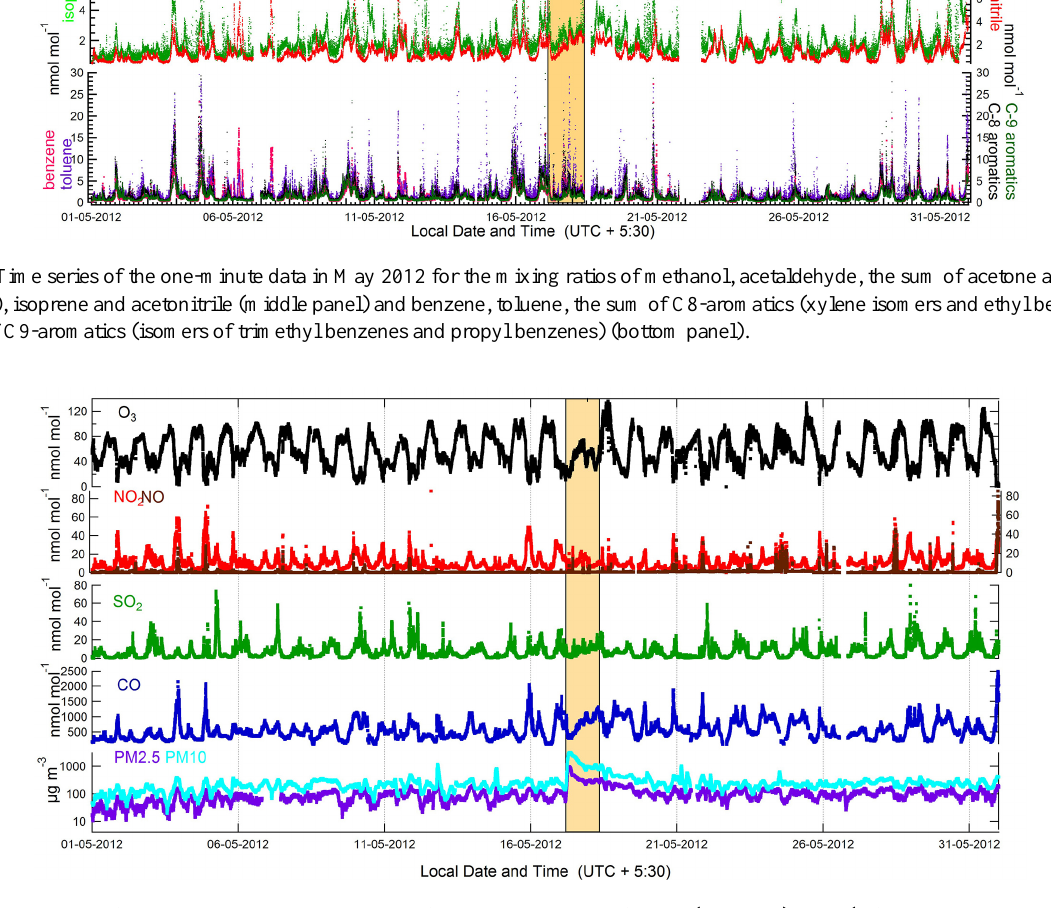
Figure 7. Time series of the one-minute data in May 2012 for the mixing ratios of ozone (top panel), NO 2 (refer to Section 2.2.3 for details of the NO x measurements) and NO (second panel), SO 2 (third panel), CO (fourth panel) and mass concentrations of PM 2 . 5 and PM 10 (bottom